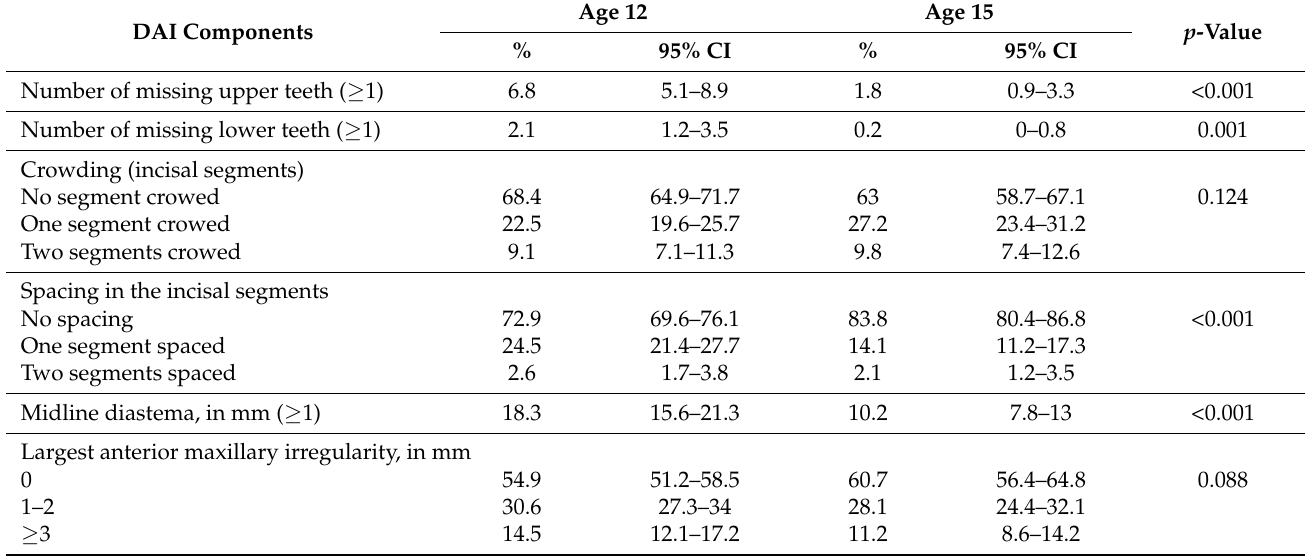
Table 7. Frequency distribution of malocclusion traits according to DAI components in 12- and 15-year-old schoolchildren. DAI